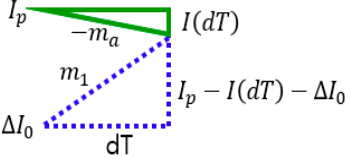
Figure 5. Comparison between sub-harmonic oscillation current and slope compensation.